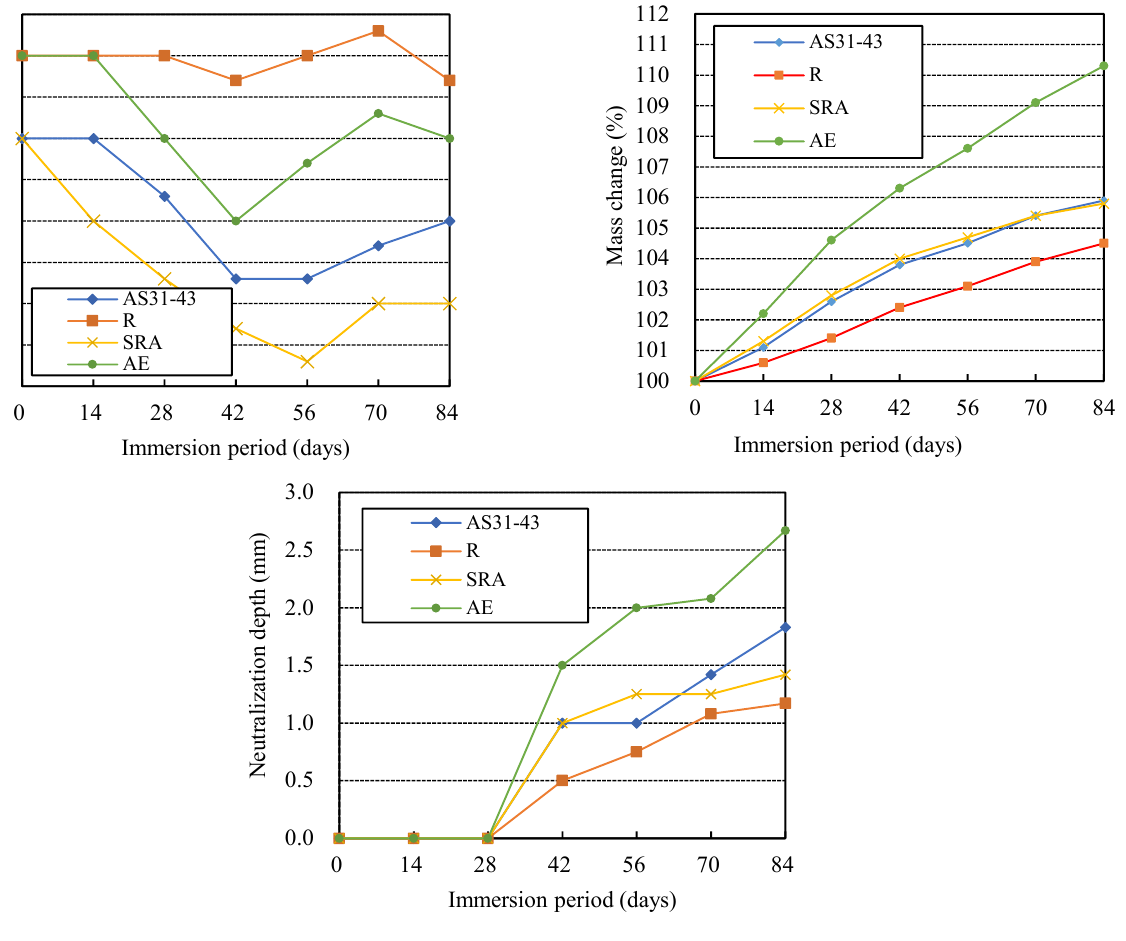
Figure 11. Effects of chemical admixture on the acid resistance of AAFS.